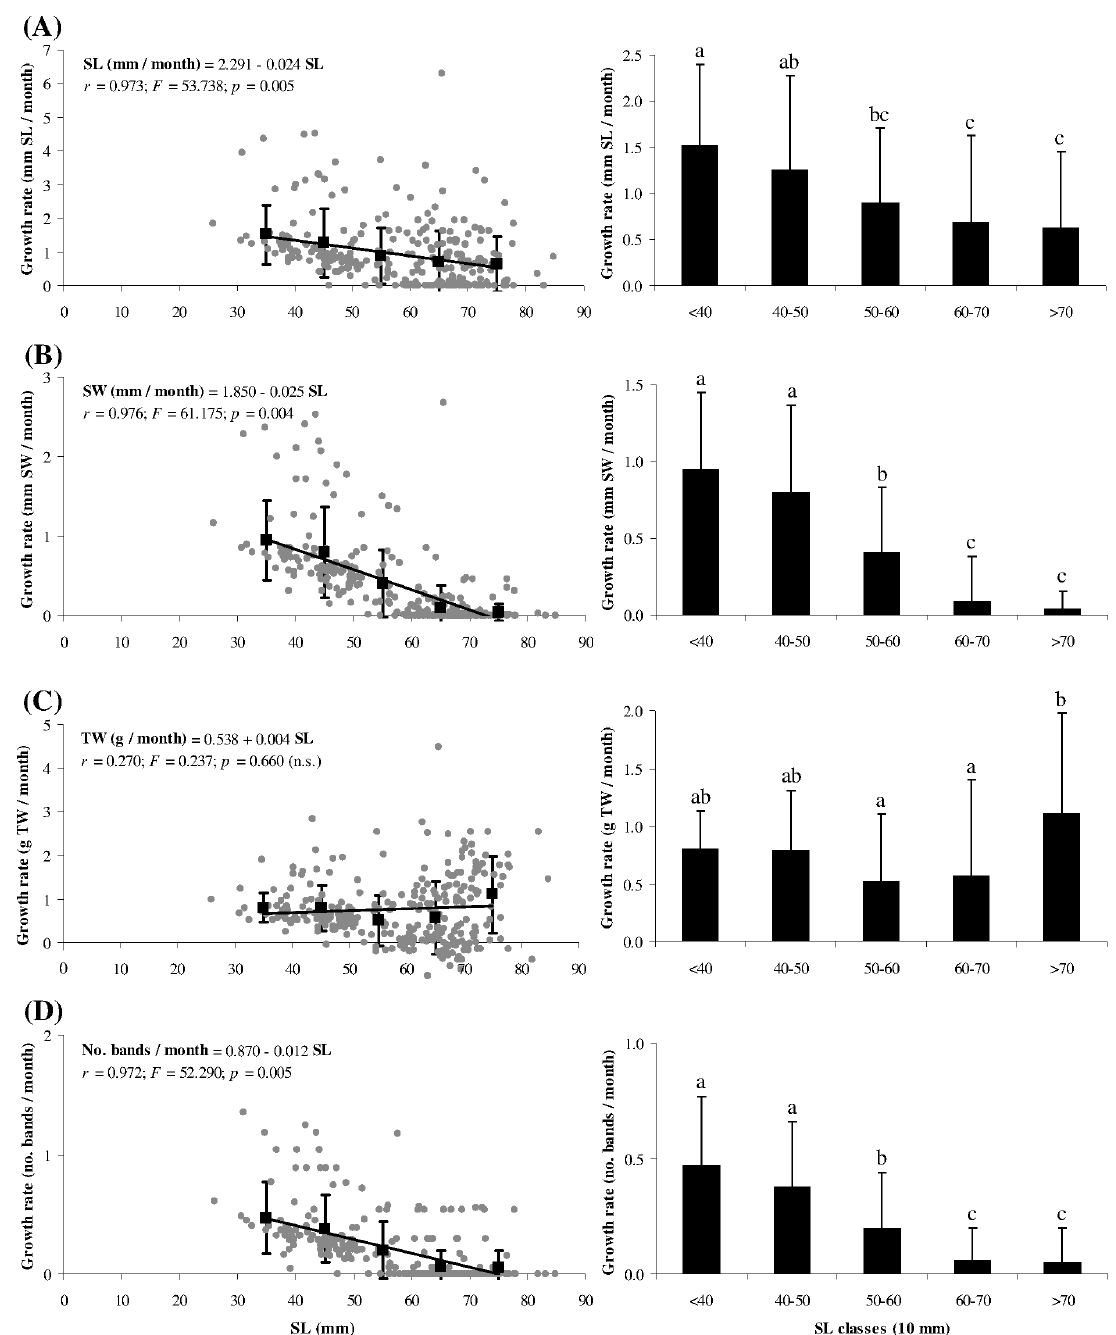
Fig. 5. − Individual growth rates of marked-recaptured Bolinus brandaris , linear regressions established between specimen size at marking (SL) and growth rates (grouped in 10 mm SL classes), and comparison of mean growth rates between size classes (10 mm SL classes). Monthly growth rates in (A) shell length (SL), (B) shell width (SW), (C) total weight (TW), (D) shell deposition (no. bands). Different super- script letters denote statistically significant differences in mean growth rates between size classes (K-W: Dunn test, p